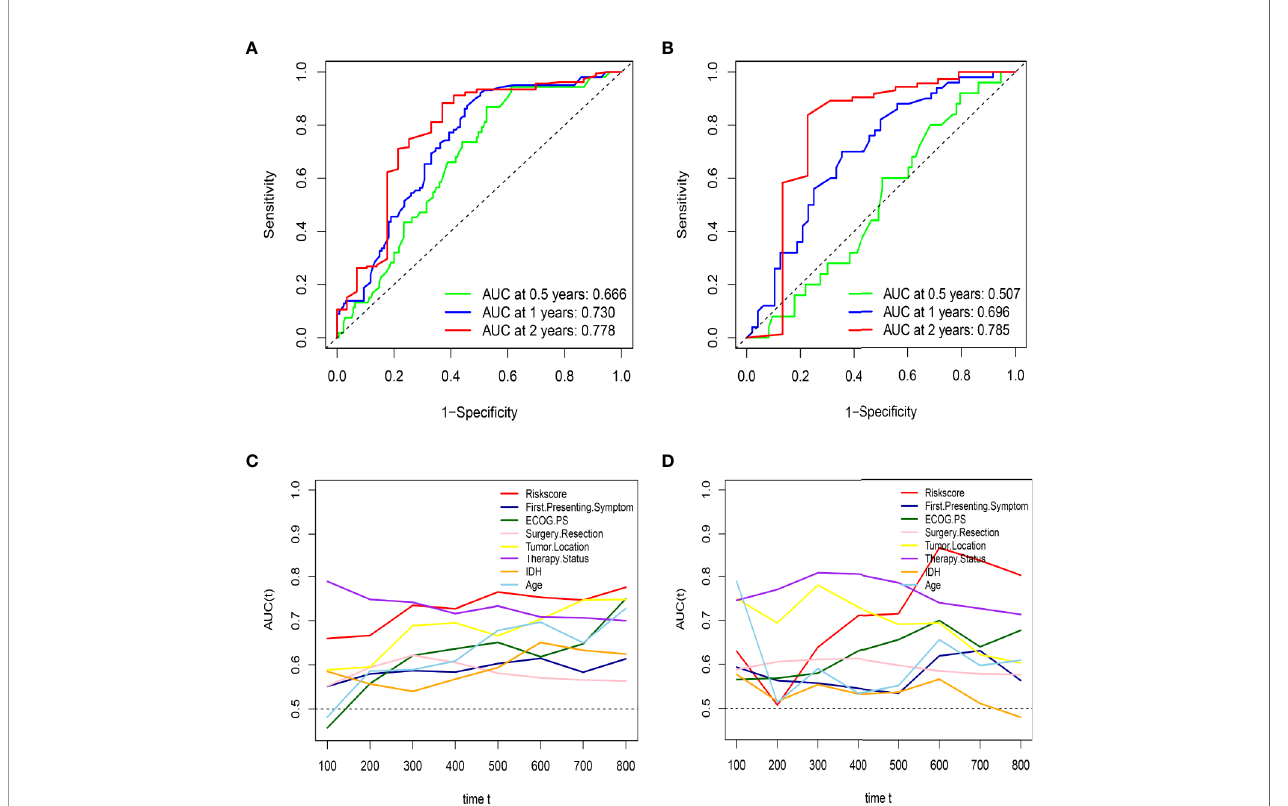
FIGURE 3 | HRS has excellent predictive ability in both the training set and external validation set. (A) the AUCs of HRS at 0.5, 1, and 2 years in the training group; (B) the AUCs of HRS at 0.5, 1, and 2 years in the external validation; (C) Time-dependent ROC curves of the HRS and important clinical characteristics in the training group; (D) Time-dependent ROC curves of the HRS and important clinical characteristics in the external validation